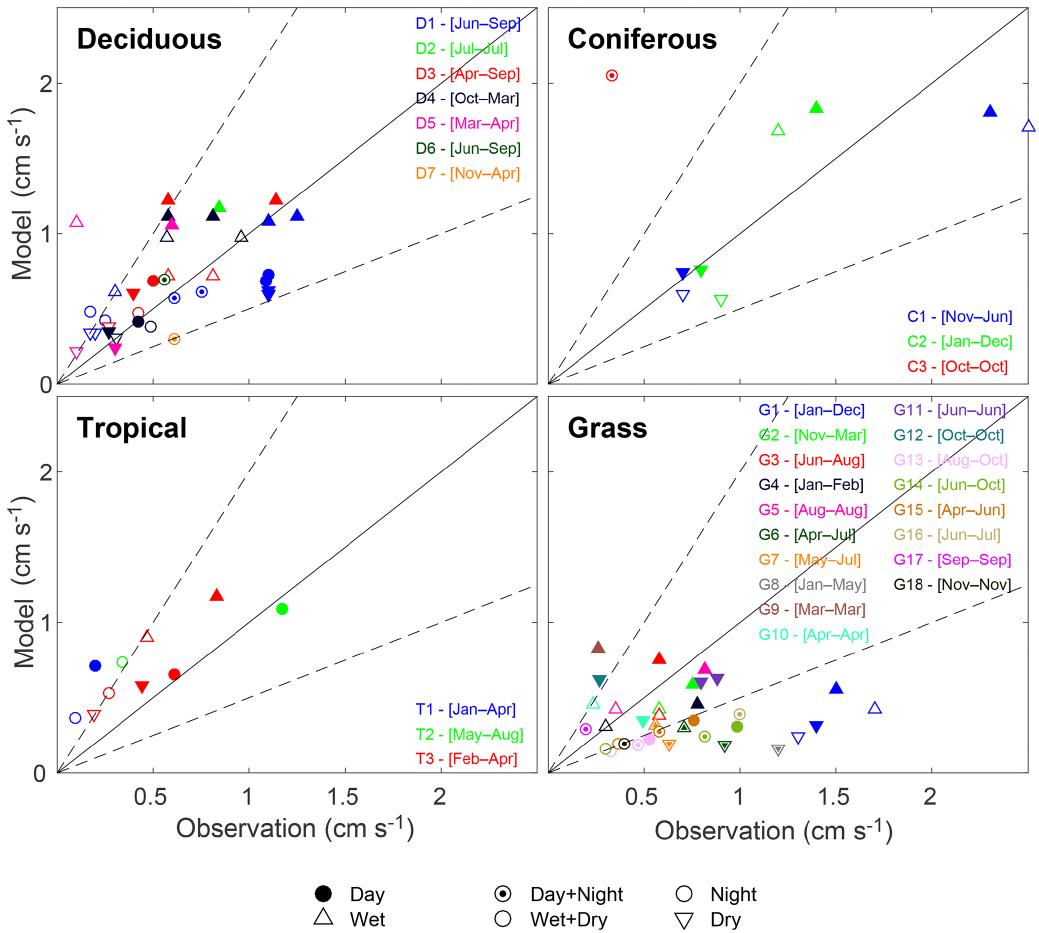
Figure 3. Observed and simulated deposition velocities of SO 2 for different vegetation types. The symbol shape indicates the canopy status: wet (upward pointing triangle), dry (downward point triangle), and circle (average). The symbol fill indicates the time period: filled (day), half-filled (day + night), and empty (night). The monthly diurnal cycle of deposition velocities simulated by AM3-LM3-DD (R2010 simulation) is sampled at each observation site in the tile that best represents the observed ecosystem accounting for the month, time of day, and canopy wetness status when the observations were collected. References for the different sites are given in Table